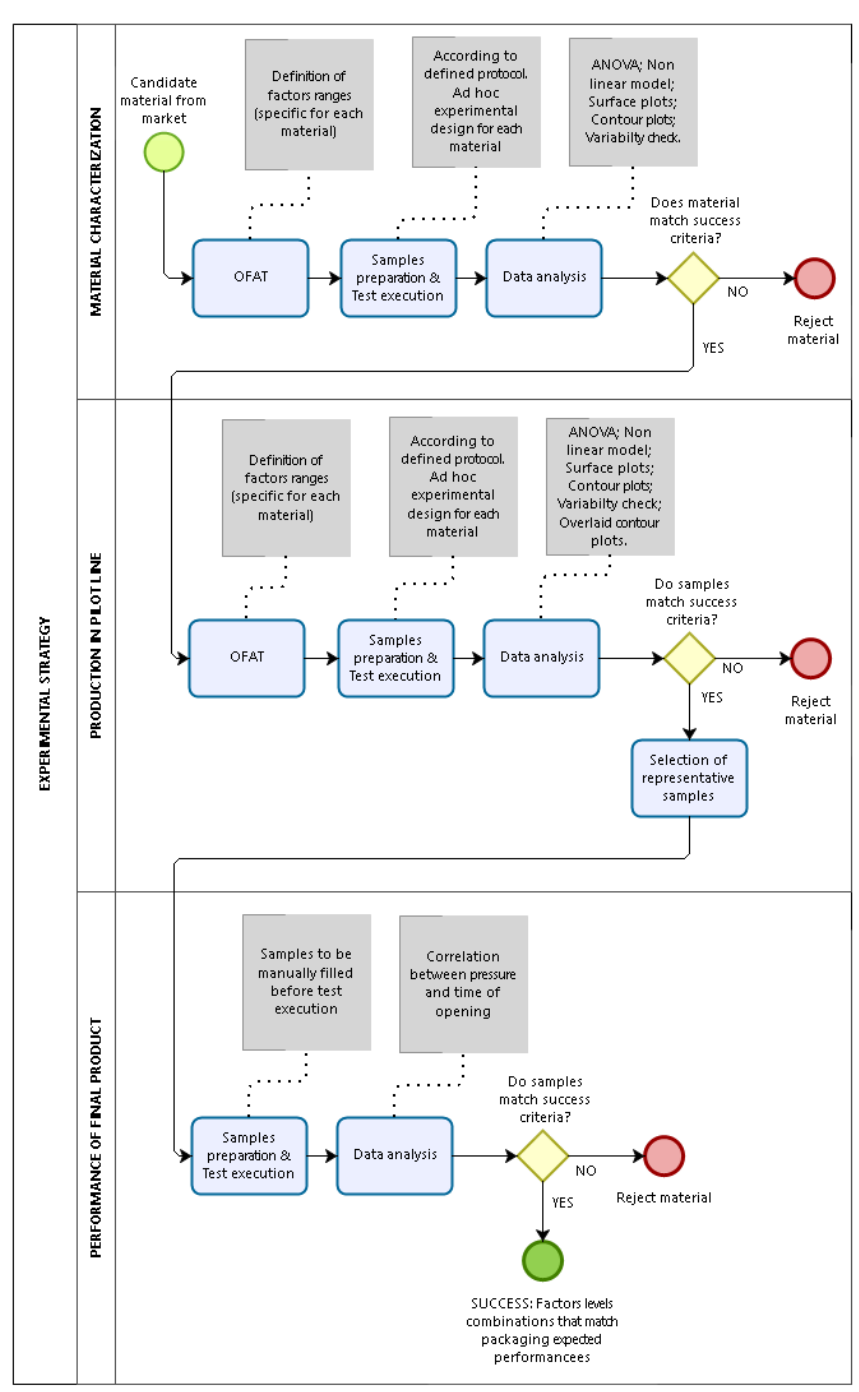
Figure 2 – Scheme of the experimental